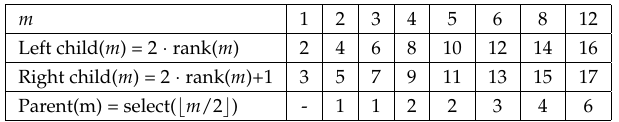
Figure 5. With the rank and select functions listed in the first column, we can navigate the binary tree in Figure 3 and compute the position node for the left child, right child or parent of the